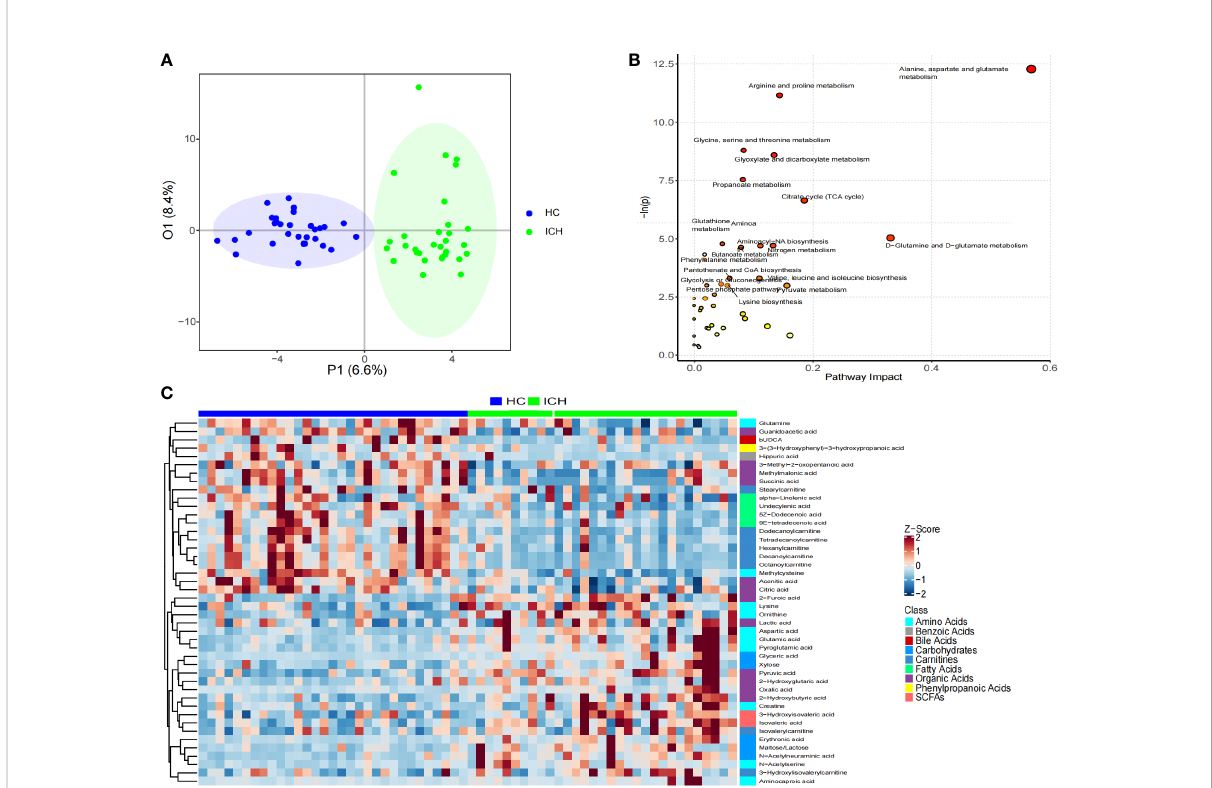
FIGURE 4 Characteristics of serum metabonomics. (A) OPLS-DA score chart; (B) Pathway analysis and statistical signi fi cance of differential metabolites in serum samples; (C) Heat maps showing relative abundances of differential metabolites screened using unidimensional and multidimensional